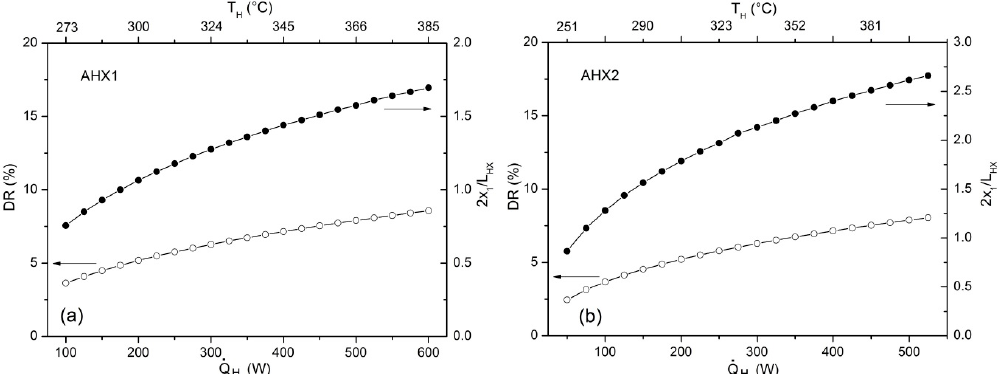
Figure 7 . The drive ratio and peak-to-peak particle displacement amplitude as a function of the input heat flux for ( a ) the HX with rectangular pore geometry and ( b ) the HX with circular pore geometry. The operation temperatures of the heater, T H , are also indicate on the horizontal scale on the top.